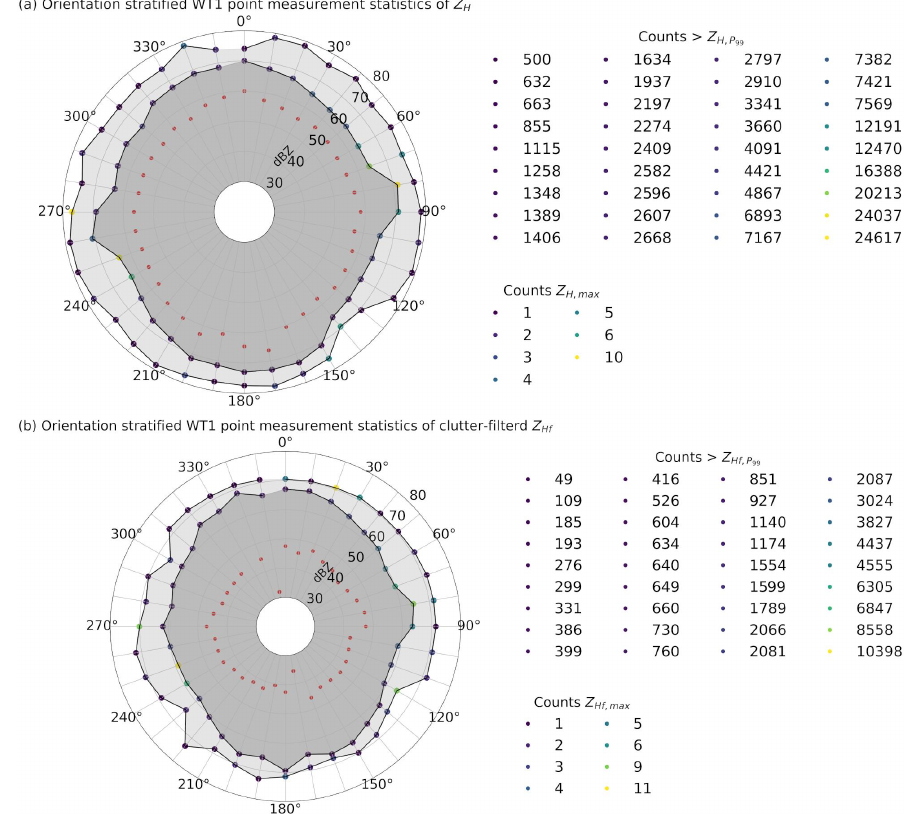
Figure 10. Fixed-pointing measurement statistics of horizontal reflectivity Z H (a) and clutter-filtered Z Hf (b) based on the relative position of the WT1 nacelle. The median value is indicated by the red scatter points in all polar projections. The maximum values with the corresponding counts within a bin width of 0 . 5dB are shown by the light-gray shaded area and color-coded scatter points. The dark shaded area represents the results for the 99th percentiles, with the counts exceeding them indicated by the corresponding color